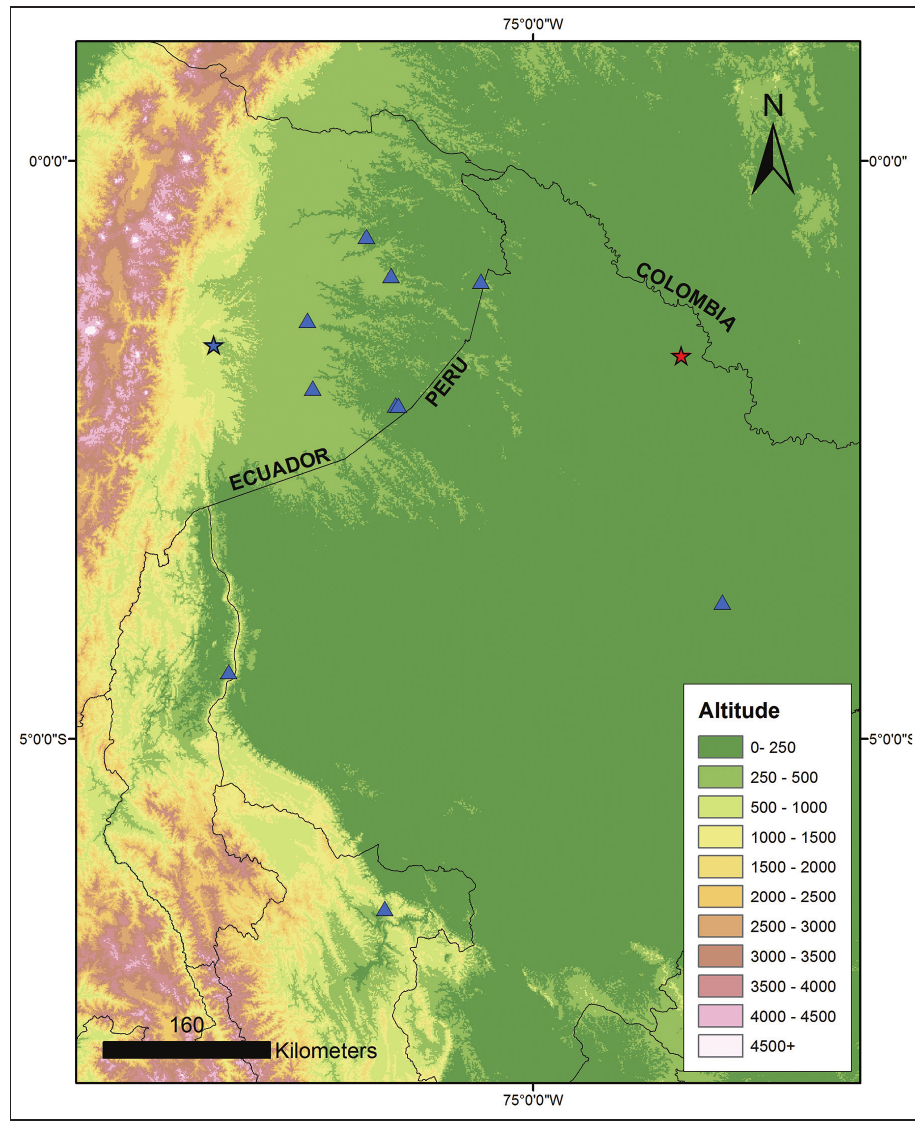
Figure 9. Records of Tepuihyla shushupe sp. n. and Tepuihyla tuberculosa comb. n. Tepuihyla shushupe sp. n., red star; Tepuihyla tuberculosa comb. n., blue triangles and blue star for type locality. Locality data from specimens deposited at Natural History Museum (BMNH), London, Centro de Ornitología y Bio- diversidad (CORBIDI), and Museo de Zoología, Pontificia Universidad Católica del Ecuador